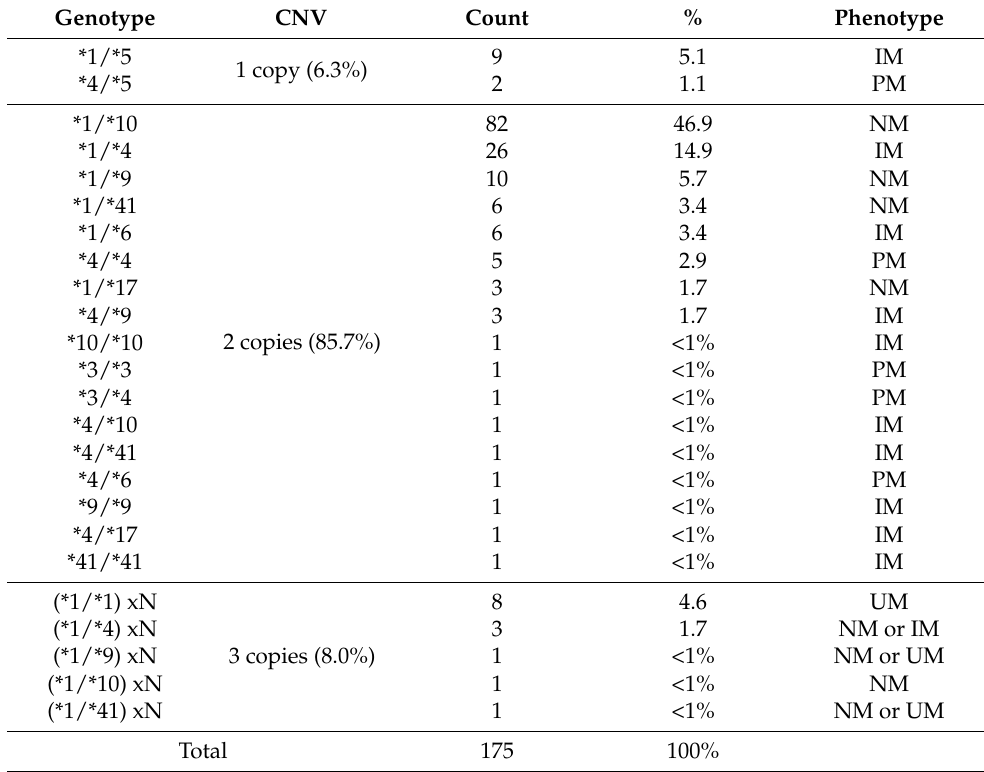
Table 5. Prevalence of CYP2D6 genotypes in a Spanish population.